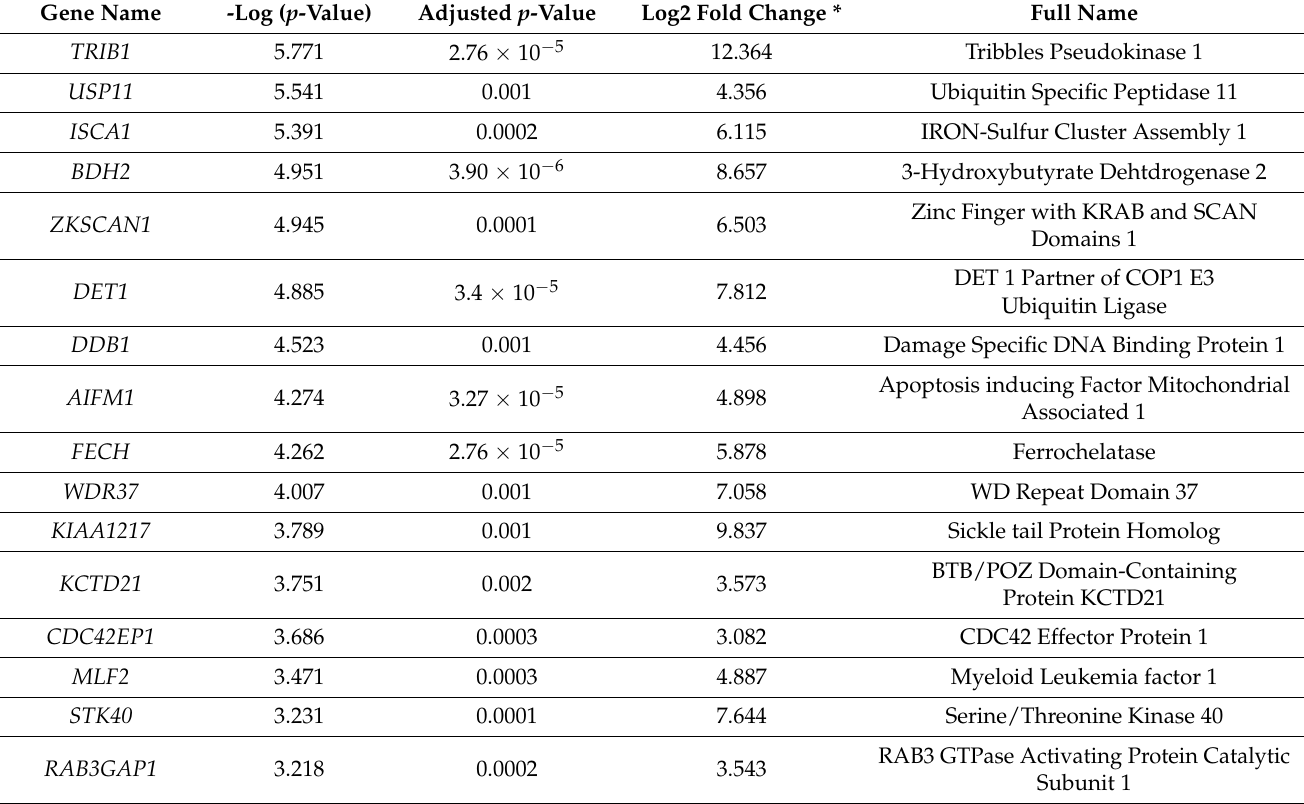
Table 2. Top 25 TRIB22 interacting partners in HEK293T cells based on p